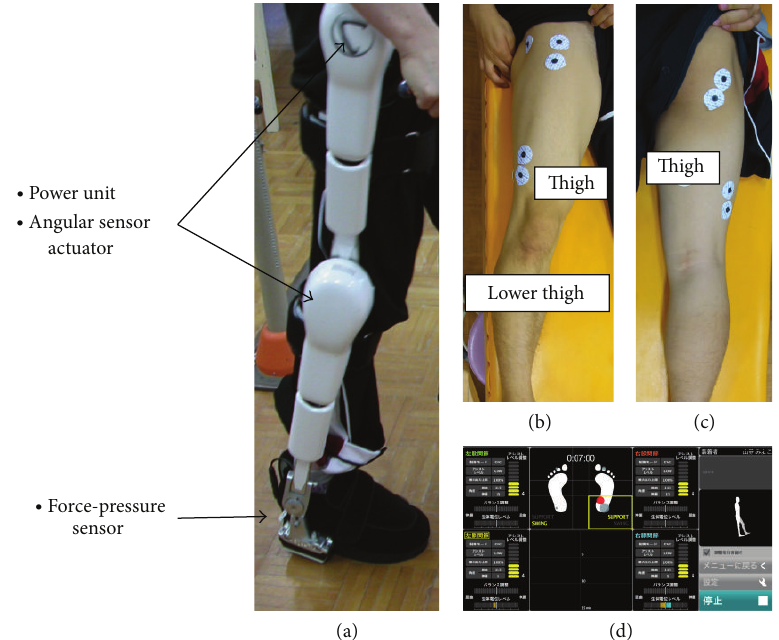
Figure 1: Newly-developed wearable robot suit, hybrid assistive limb (HAL). The HAL suit has power units and force-pressure sensors in the shoes. The power units consist of angular sensors and actuators on bilateral hip and knee joints (a). Muscle action potentials are detected through the electrodes on the anterior and posterior surface of the thigh ((b), (c)). Assist levels and force-pressure are shown on a computer monitor (d).